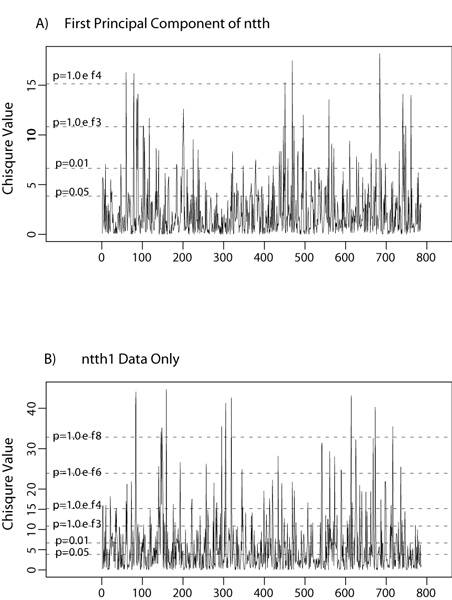
ntth chi-square values for chromosome 4 SNPs.